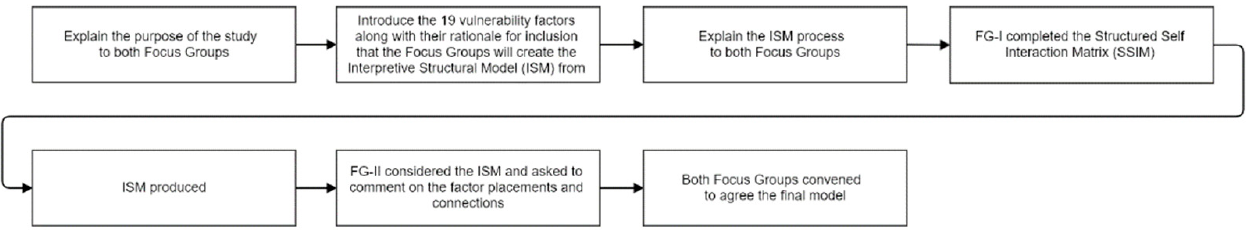
Figure 3. Creating the structural model from the vulnerability factors.